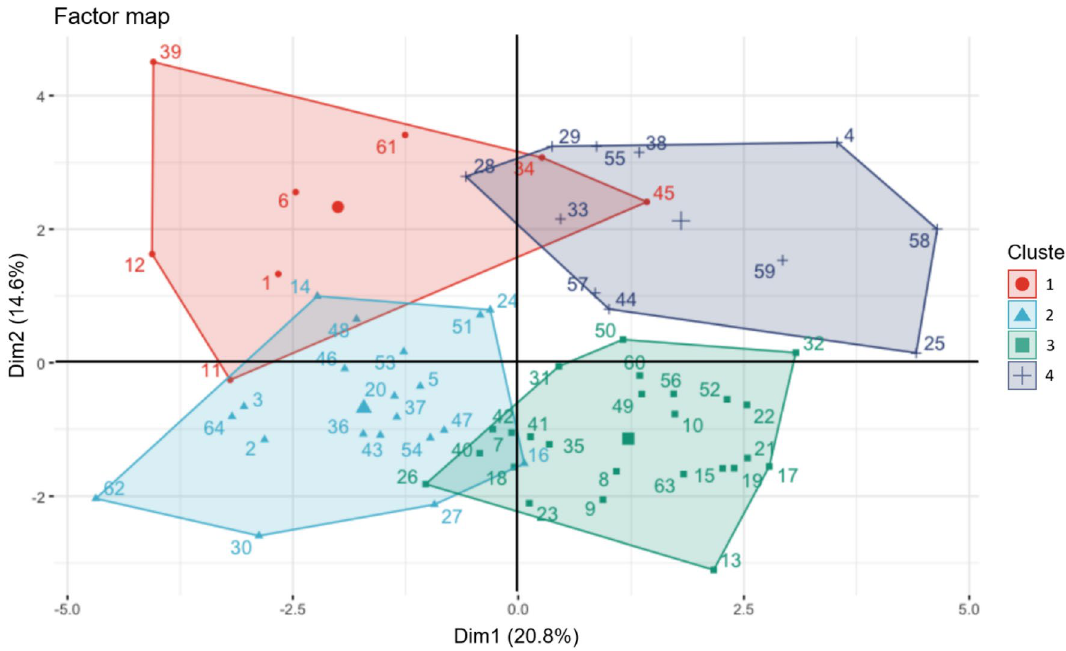
Figure 5. Mapping of the clusters as a function of PCAmix axes: Dim2 y-axis, Dim1 x-axis as in Fig. 4. Individuals are numbered and colored according to their cluster. The barycenter of each cluster is represented by a larger